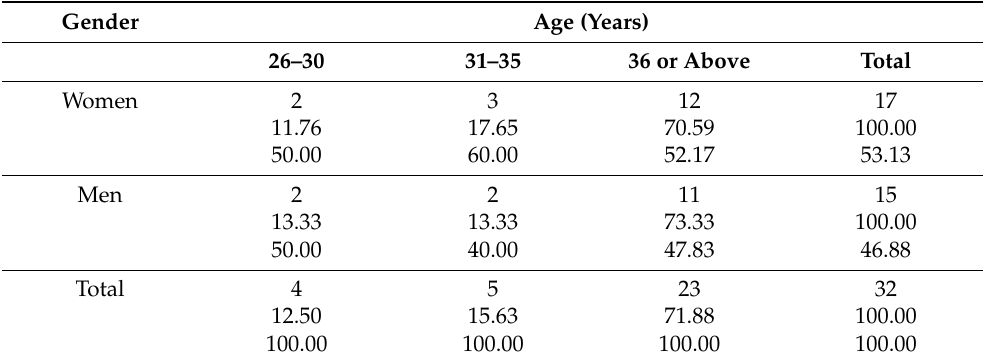
Table 4. Analysis of gender by age.